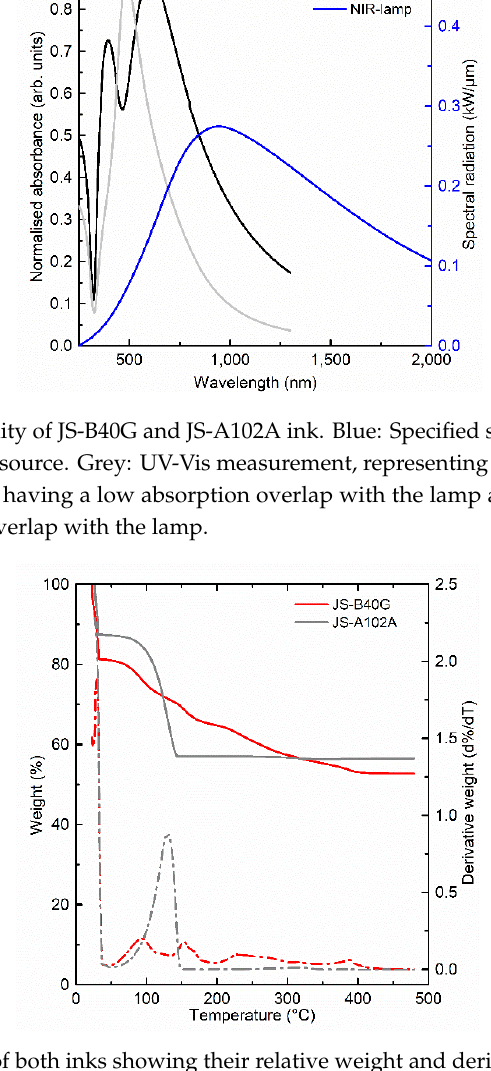
Figure 7. Measurement of both inks showing their relative weight and derivative weight. The weight loss (which correlates with the evaporation) of JS-A102A is very abrupt compared to the gradual loss of the non-NIR optimized JS-B40G ink, confirming the faster evaporation rate of JS-A102A. Secondly, the evaporation happens at lower temperatures.